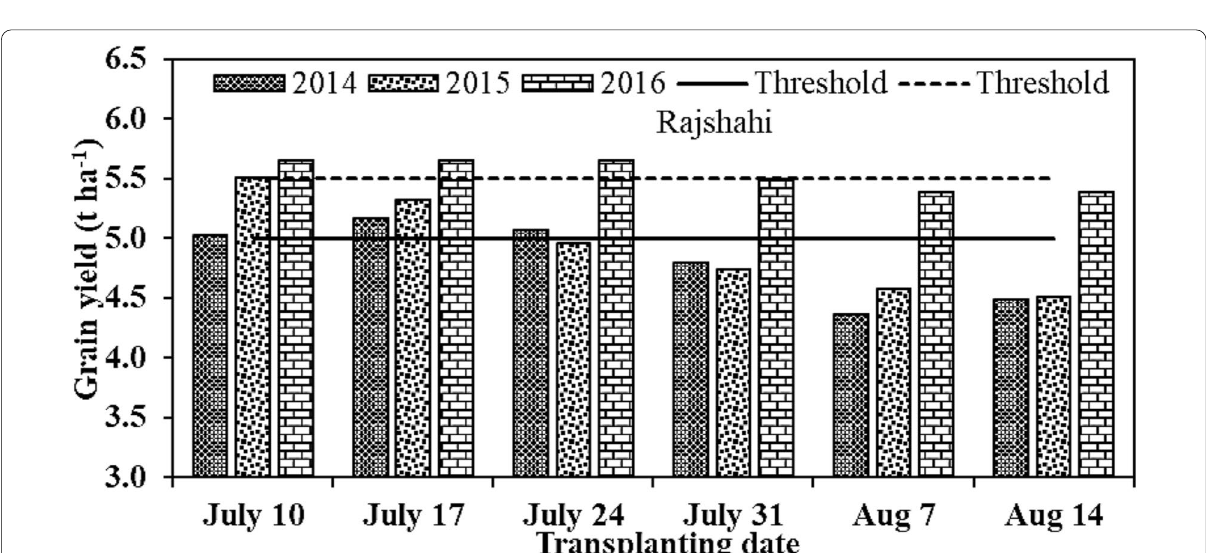
Fig. 6 Yield comparison of BR11 with threshold limit under varying transplanting date in